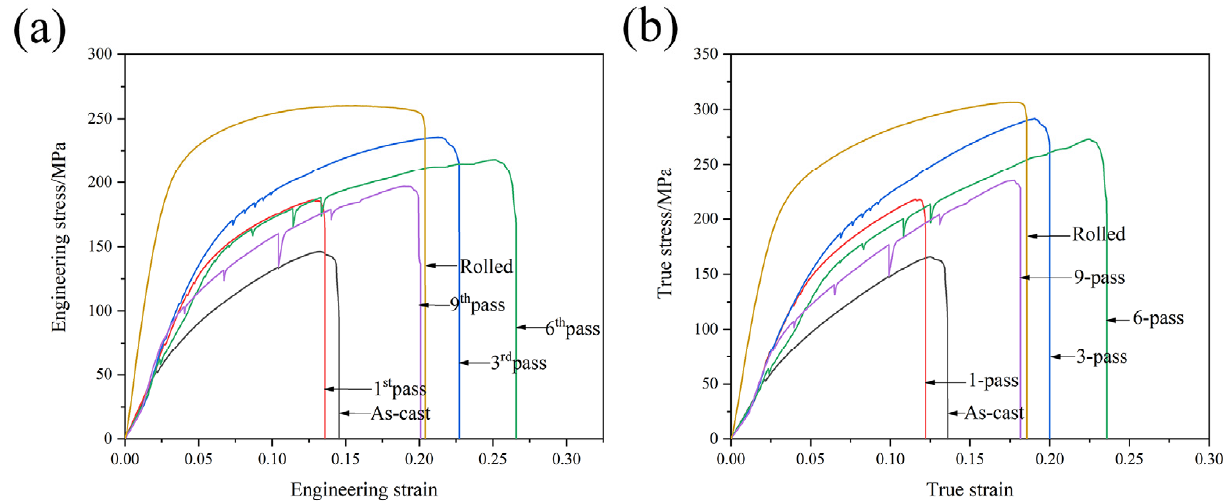
Figure 3. Room temperature tensile curves of GAZ 211 alloy: ( a ) engineering stress–strain curves and ( b ) true stress–strain curves.